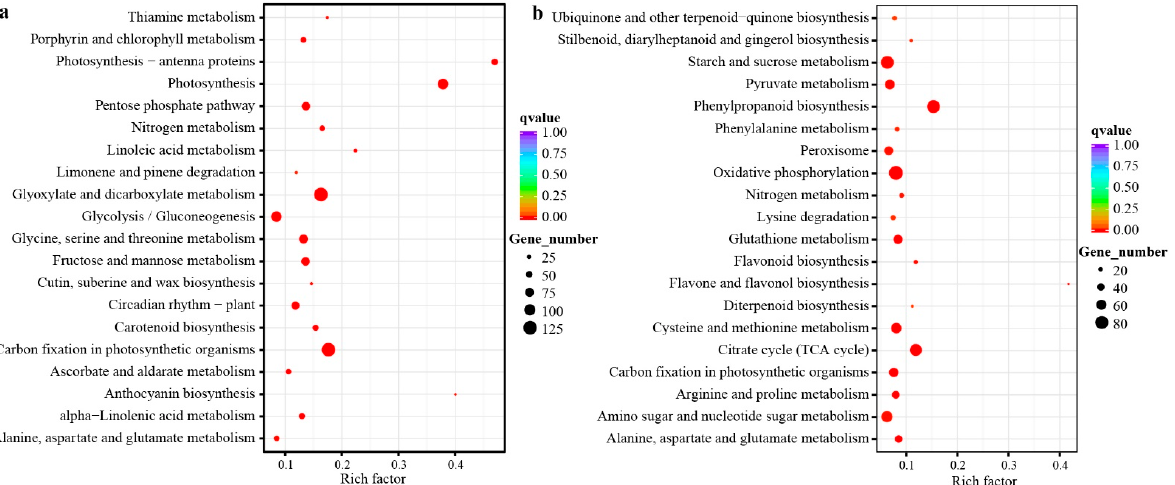
Figure 3. Top 20 enriched KEGG pathways among DEGs. These DEGs were classified into the down-regulated ( a ) and the up-regulated ( b ) pathways in NA samples compared with CO conditions, respectively. The circle size represents the number of enriched gene numbers, and the color is for the threshold of enrichment.